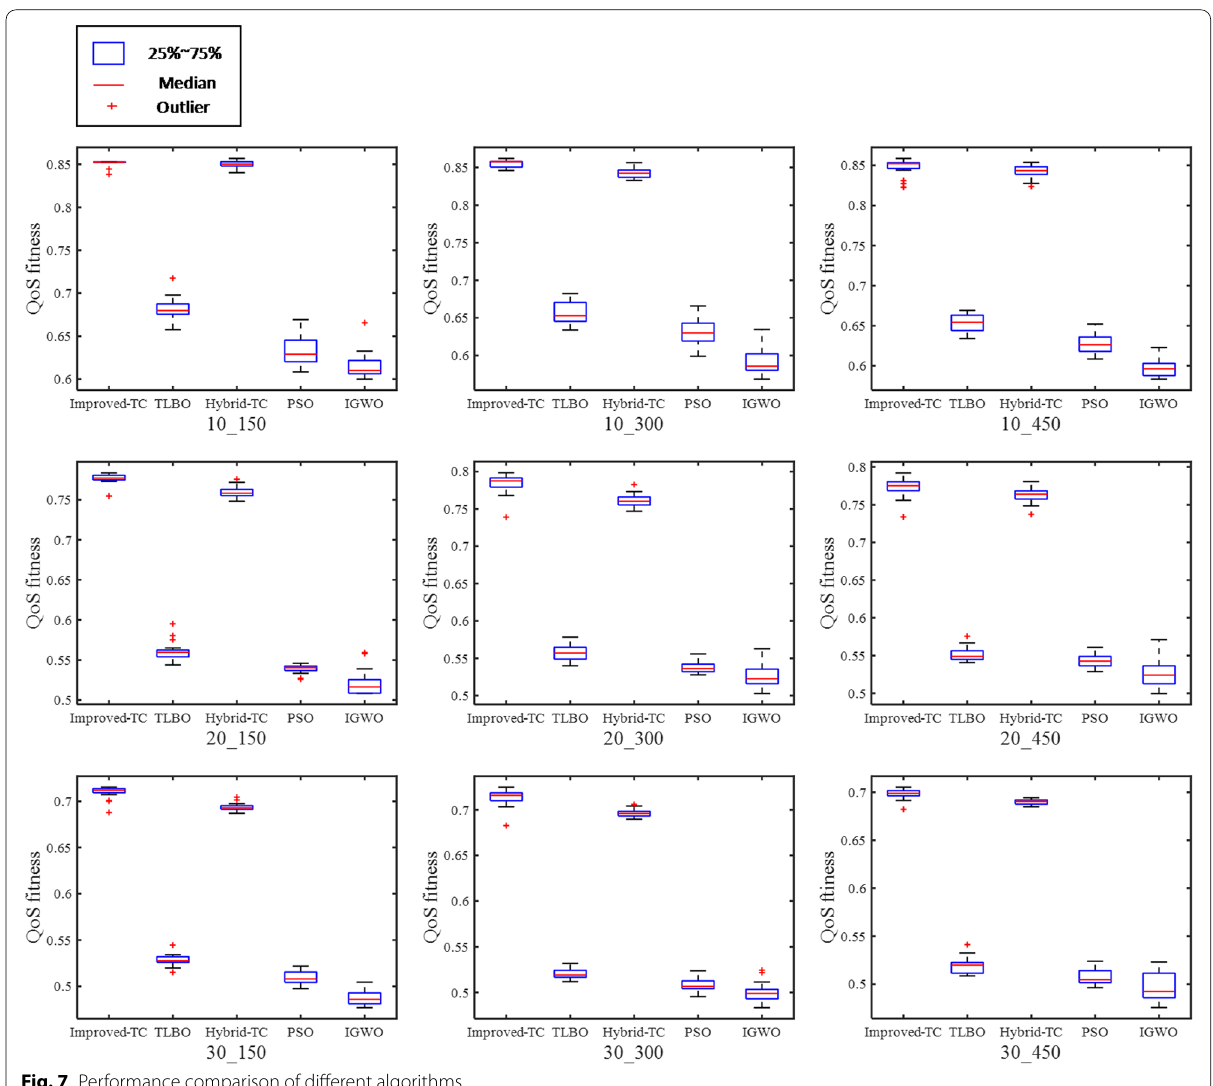
Fig. 7 Performance comparison of different algorithms